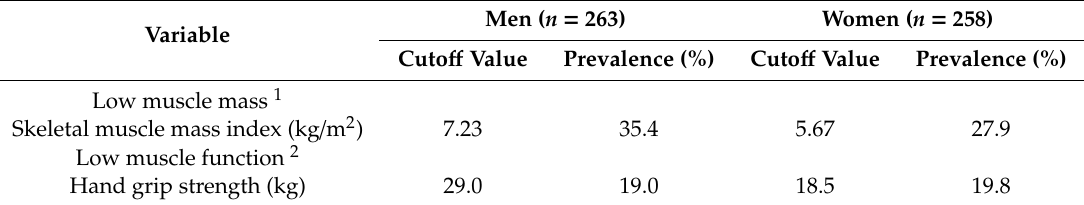
Table 3. The cuto ff values and prevalence of low muscle mass and low muscle function.